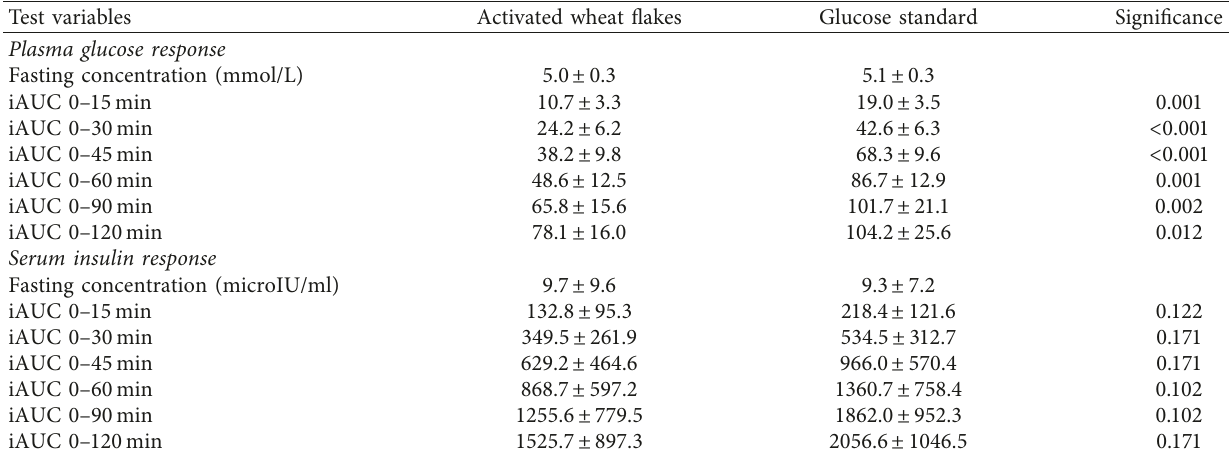
Table 2: Plasma glucose response, expressed as iAUC (in mmol ∗ min/L), and serum insulin response, expressed as iAUC (in microIU ∗ min/ mL) after a meal of activated wheat flakes or a glucose standard.